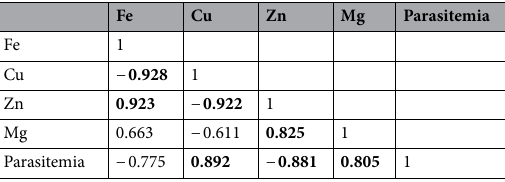
Table 4. Pearson correlation between Fe, Cu, Zn and Mg and parasitemia. Significant values are in bold.